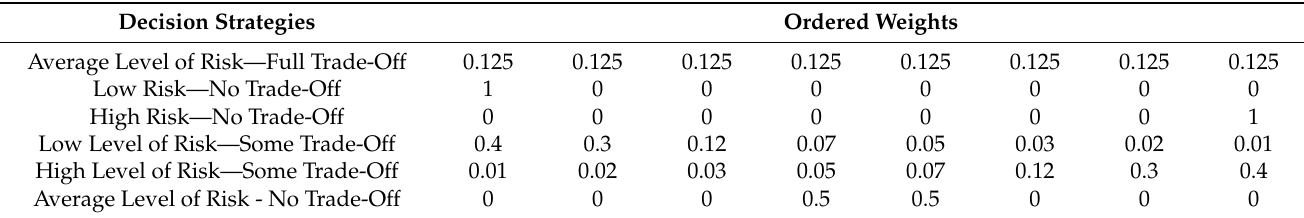
Table 4. Ordered weights used in different